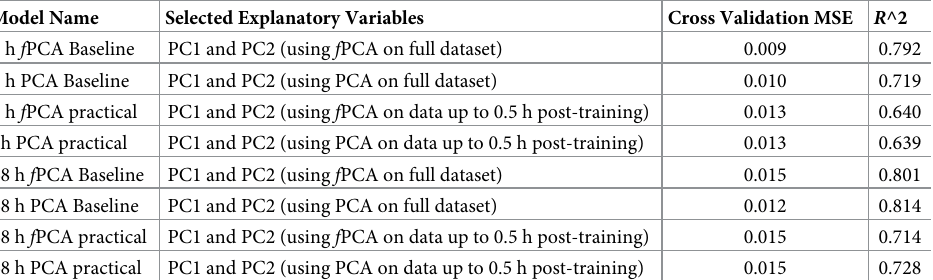
Table 2. A list of the linear mixed effects models investigated for the prediction of rel PeakF, detailing the covari- ates in each model (a common covariate in each model was an athlete random effect), mean squared error, cross validation mean squared error and variable selection results.